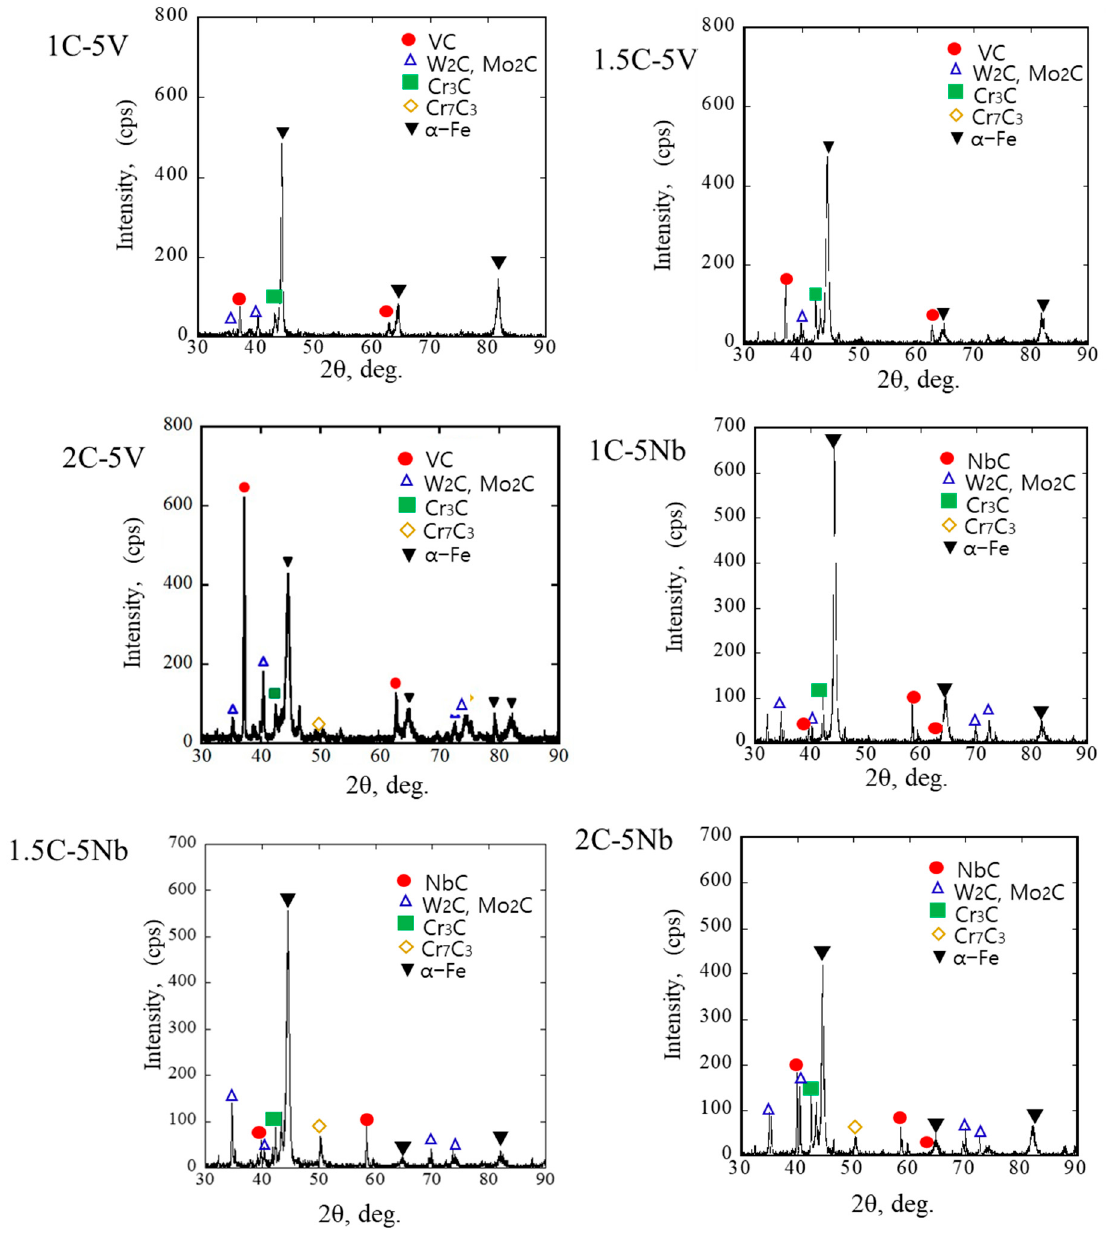
Figure 7. X-ray diffraction (XRD) patterns for each studied alloy.